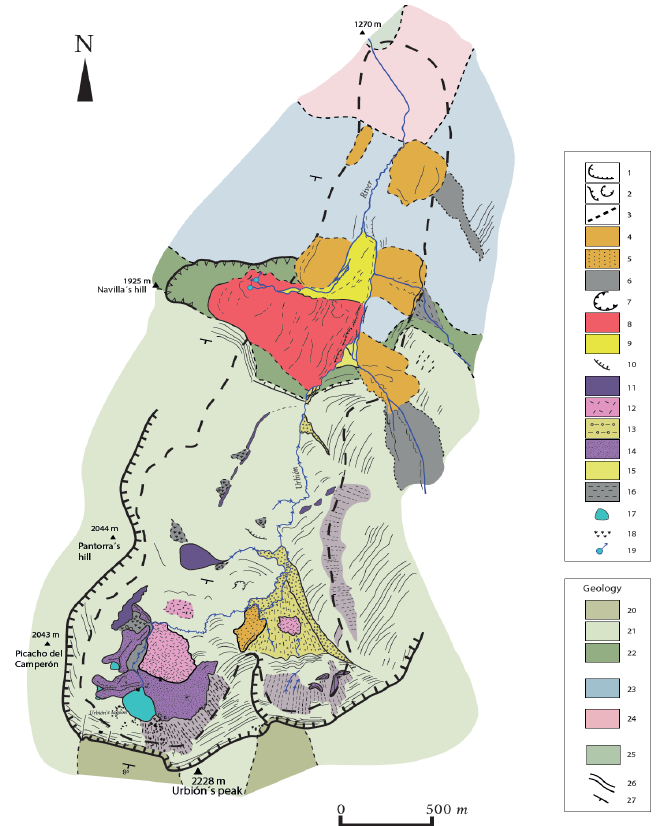
Figure 2. Geomorphology of the valley of glacial origin of the Picos de Urbión (modified from [38]). Glacial geomorphology and slope forms: 1. Glacial cirque boundary; 2. Scarp of glacial erosion; 3. Maximum limit of ice spread; 4. Lateral moraine; 5. Medial moraine; 6. Lateral obturation moraine deposits; 7. Landslide scar; 8. Landslide. Gravitational motion; 9. Alluvial fan induced by landslide; 10. Scarp in the landslide foot and alluvial fan; 11. Recessional lateral moraines; 12. Undifferentiated till; 13. Tills removed by stream waters. Alluvials built by the erosion of moraines; 14. Protalus rampart; 15. Recent alluvial fan; 16. Debris and boulders; 17. Glacial lagoon; 18. Ponds, old glacial lagoons, hydromorphic soils; 19. Springs. Bedrock Geology: Facies belonging to the late Jurassic- Lower Cretaceous of the Cameros Basin; 20. Conglomerates, Urbion Group; 21. Sandstones and lutites. Oncala Group. Grupo Oncala; 22. Lutites, clays, marls and sandstones. Tera Group. Marine Jurassic; 23. Limestones. Triassic; 24. Sandstones, dolomites and clays. Paleozoic; 25. Quartzites; 26. Stratification traces. Competent layers; 27.